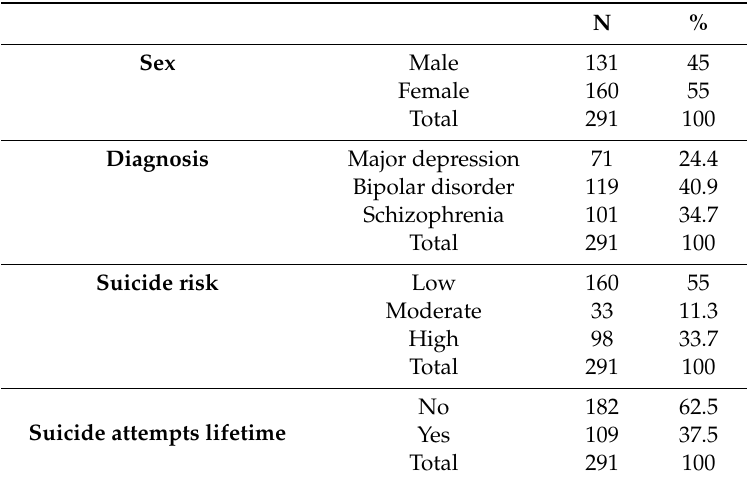
Table 1. Demographic